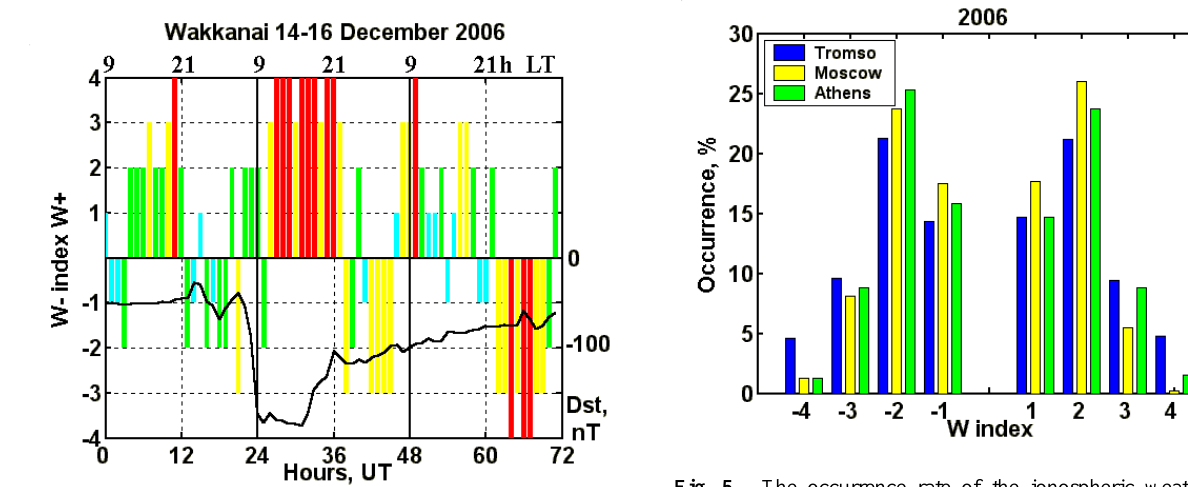
Fig. 5. The occurrence rate of the ionospheric weather index at high latitude (Tromso), mid-latitude (Moscow) and low-mid- latitude (Athens) during the year of solar